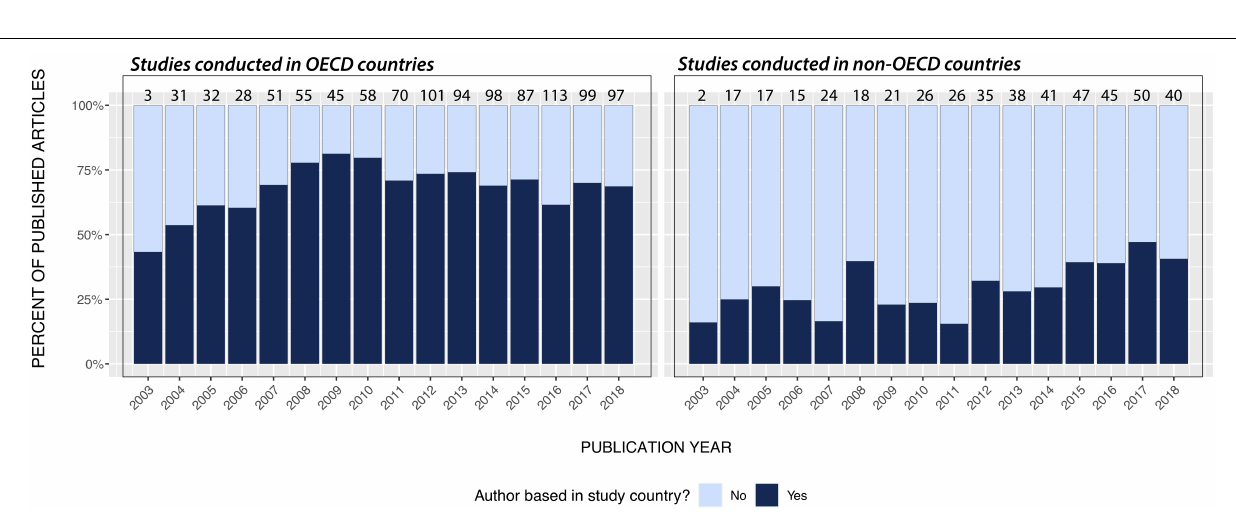
Frontiers in Marine Science |